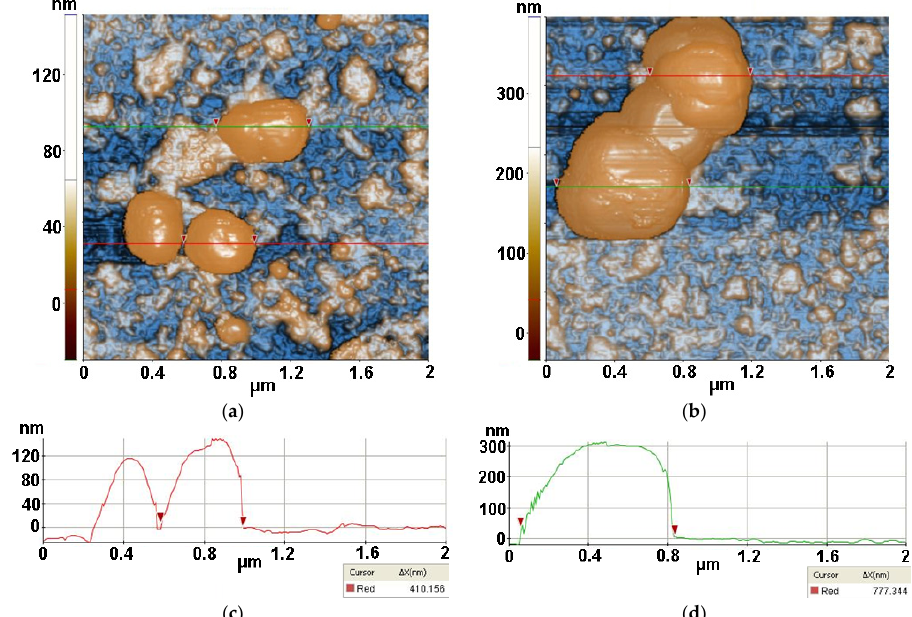
Figure 12. Two-dimensional AFM images of S. aureus (from inoculum) with TiO 2 deposited on glass substrate, after 30 min of irradiation, recorded at the scale of (2 μ m × 2 μ m) in two different areas ( a , b ), with two characteristic surface profiles for each image in red ( c ) and green ( d ). The S. aureus /TiO 2 sample from Figure 12a is characterized by the following roughness parameters: Rq = 29.34 nm and Rpv = 181.22